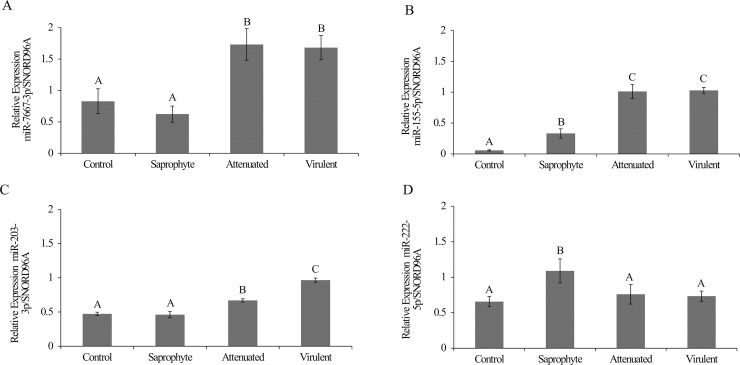
qRT-PCR of miRNA expression levels in macrophages infected with different strains of Leptospira compared to non-infected controls.A) Relative expression of miR-7667-3p, B) Relative expression of miR-155-5p, C) Relative expression of miR-203-3p, D) Relative expression of miR-222-5p. Different superscript letters differ significantly (p<0.05).